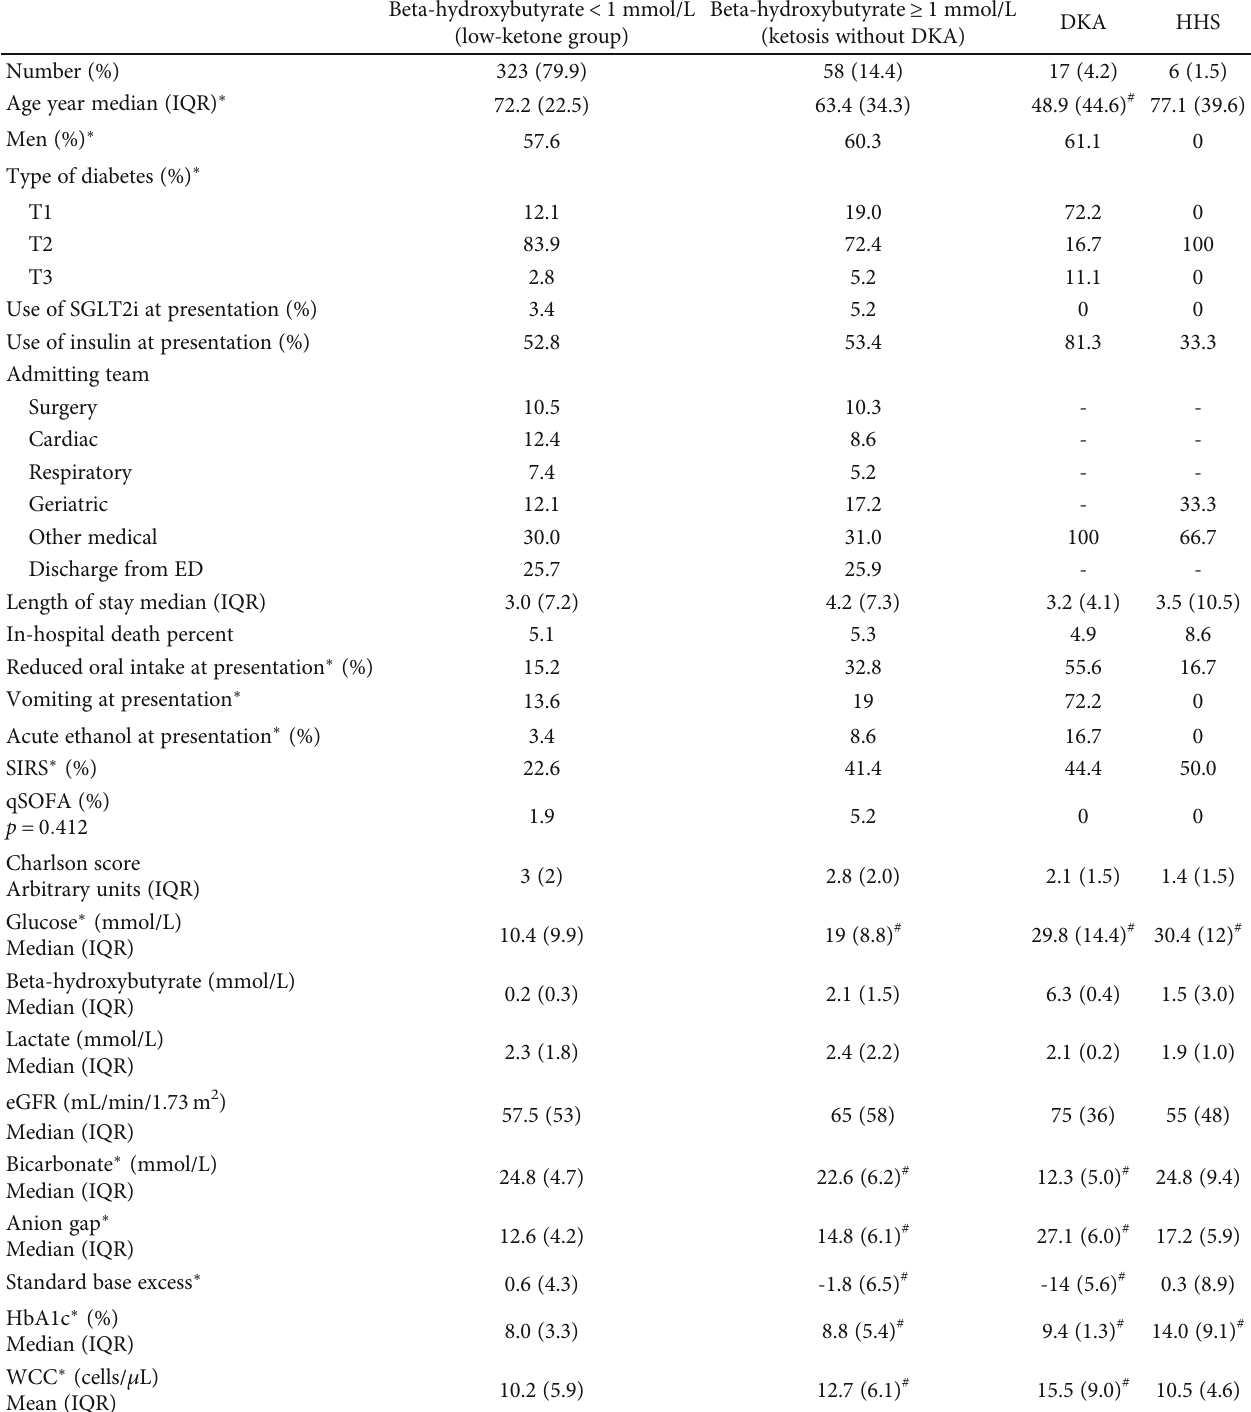
Table 1: Characteristics of patients with diabetes presenting to the emergency department, strati fi ed by beta-hydroxybutyrate category or presence of hyperglycemic